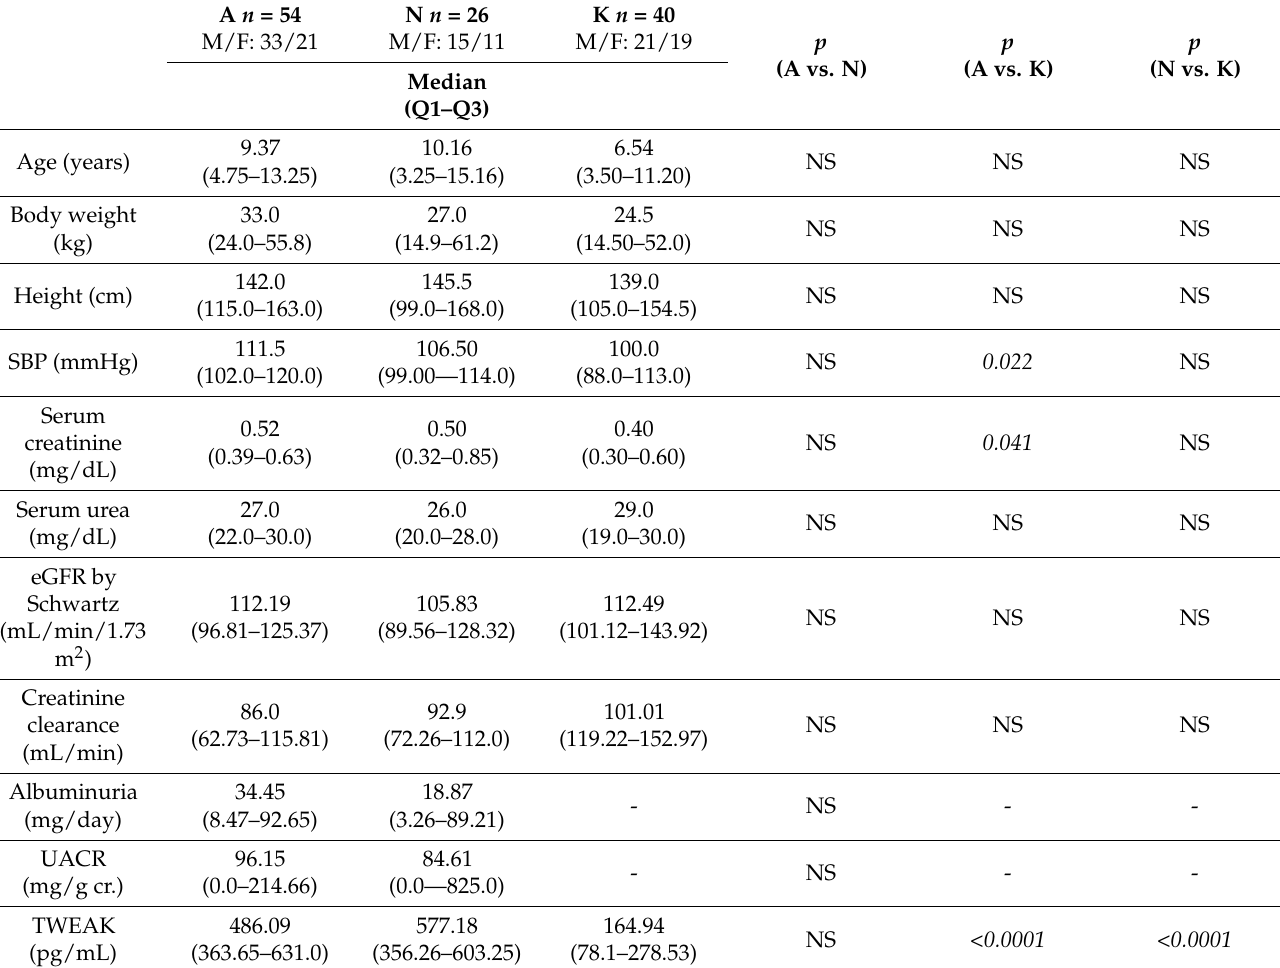
Table 1. Demographic, anthropometric, biochemical parameters, and estimated biomarkers in patients with solitary functioning kidney (groups A and N) and healthy peers; comparisons between estimated